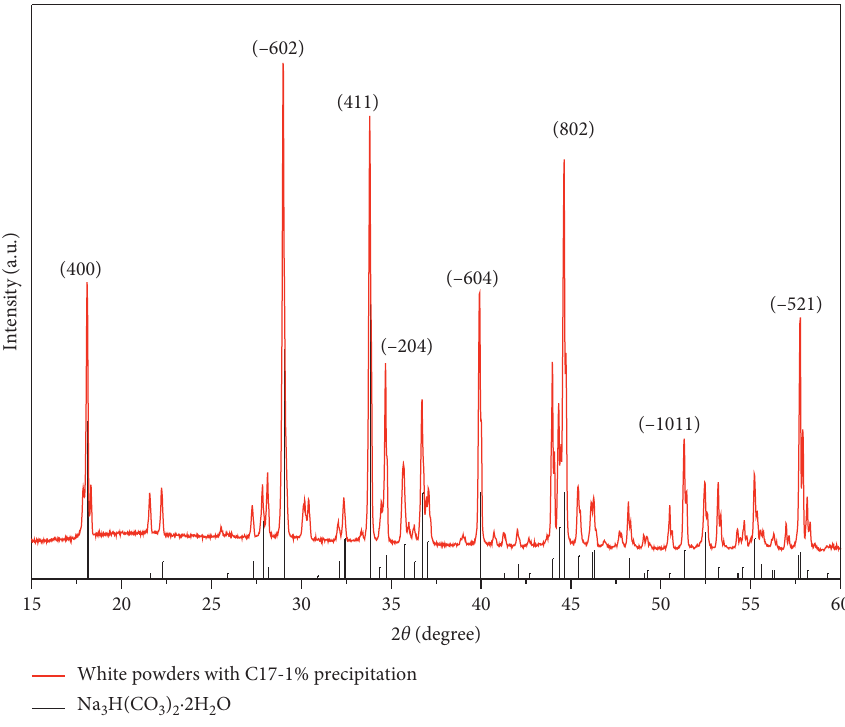
Figure 4: XRD patterns of precipitation in the C17-1% samples.